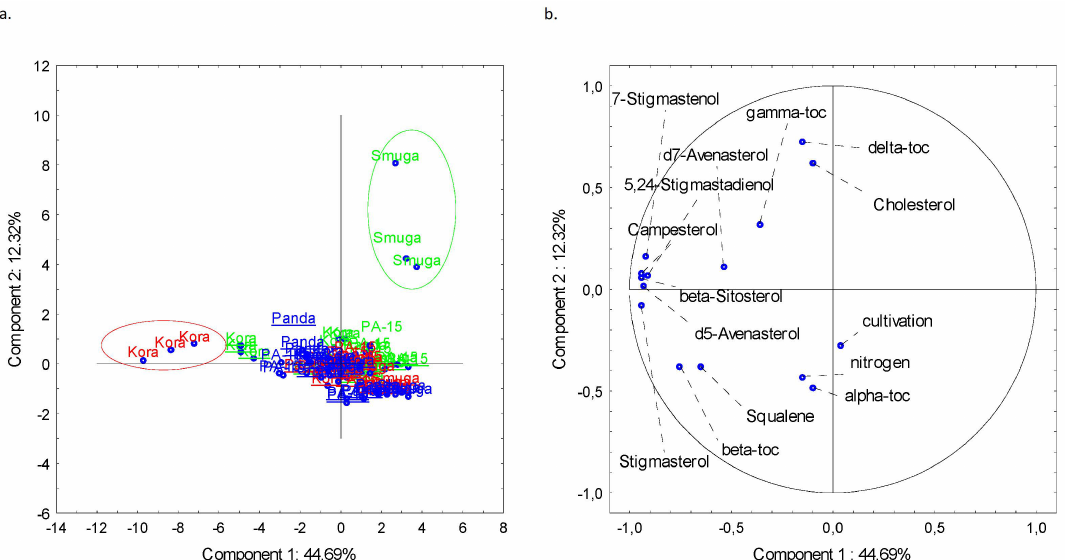
Figure 2. Two-dimensional plot representing the PCA: loading plot ( a ), and score plot ( b ). Green color- fertilization with 0 kg/ha of N 2 ; red color-fertilization with 50 kg/ha of N 2 ; blue color-fertilization with 100 kg/ha of N 2 ; Underline-cultivation with plow tillage,